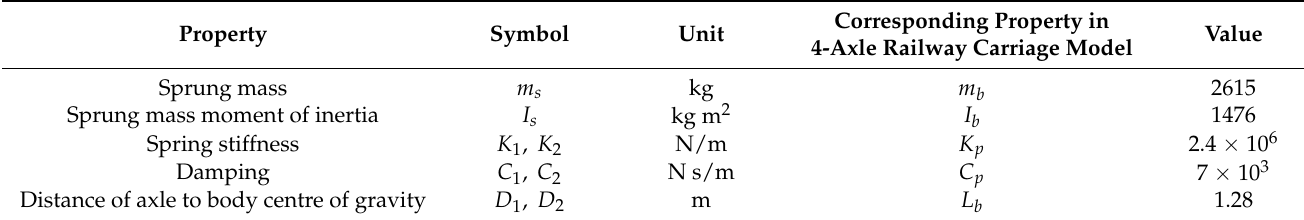
Table 6. Half car vehicle properties in the blind